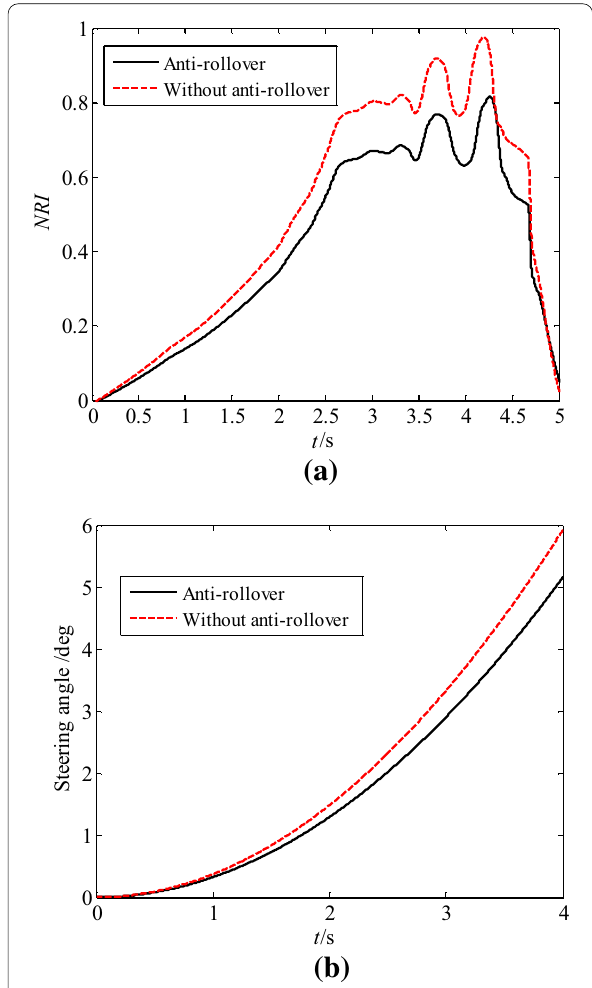
Figure 11 Rollover stability of the intelligent heavy truck in Scenario 2: ( a ) NRI; ( b ) The front wheel steering